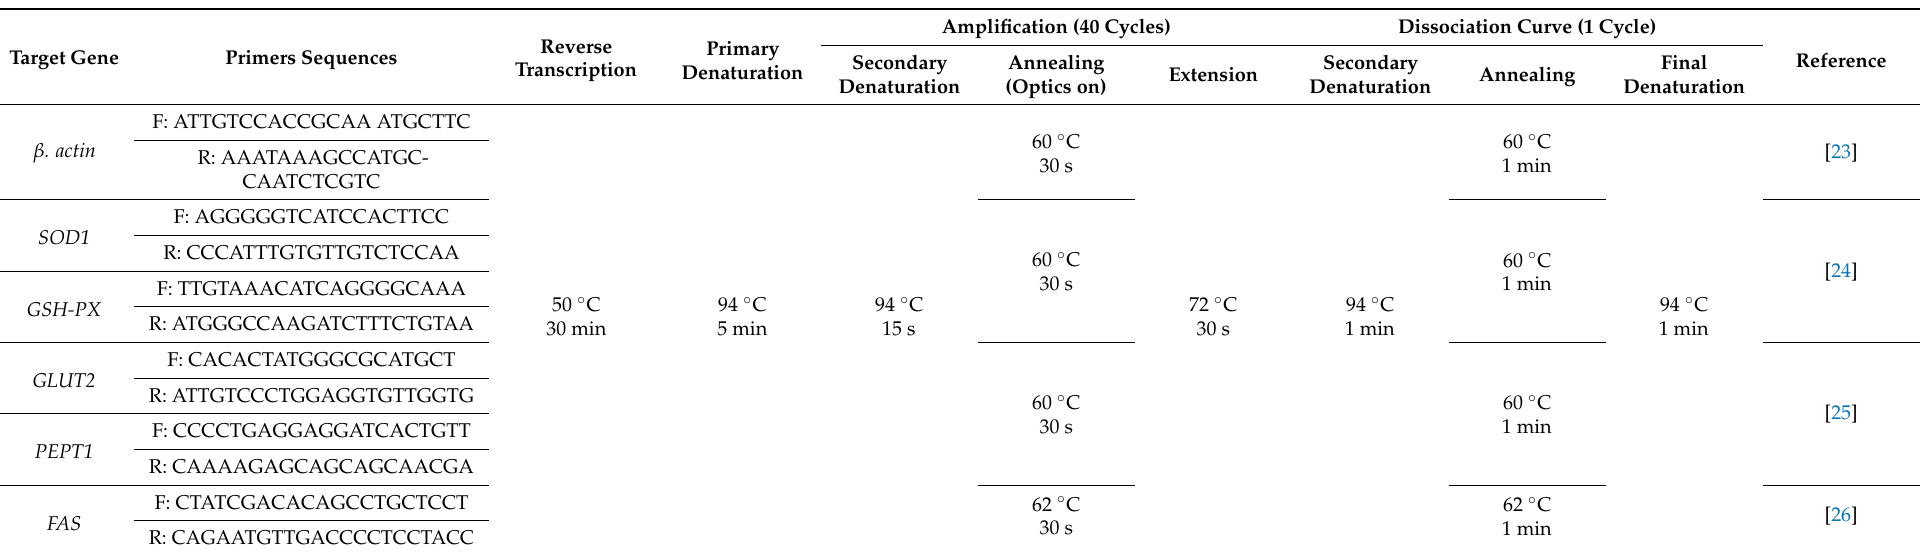
Table 4. Primer sequences, target genes, amplicon sizes and cycling conditions for SYBR green